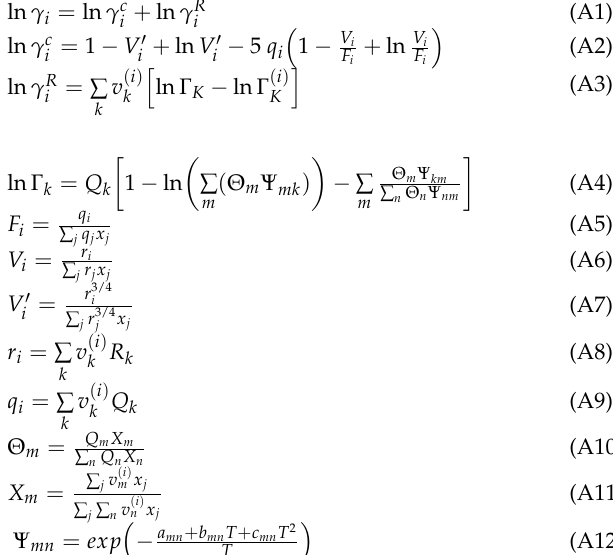
Table A1 compiles the information of the group assignment and volume ( R k ) and area numbers ( Q k ) for the compounds used in this study. Table A2 presents the interaction parameters between the groups listed in Table A1 [31,57]. Table A1. Group assignment, volume and area numbers of different compounds based on UNIFAC-Dortmund methodology. Compound Formula Structure GROUP Assignment